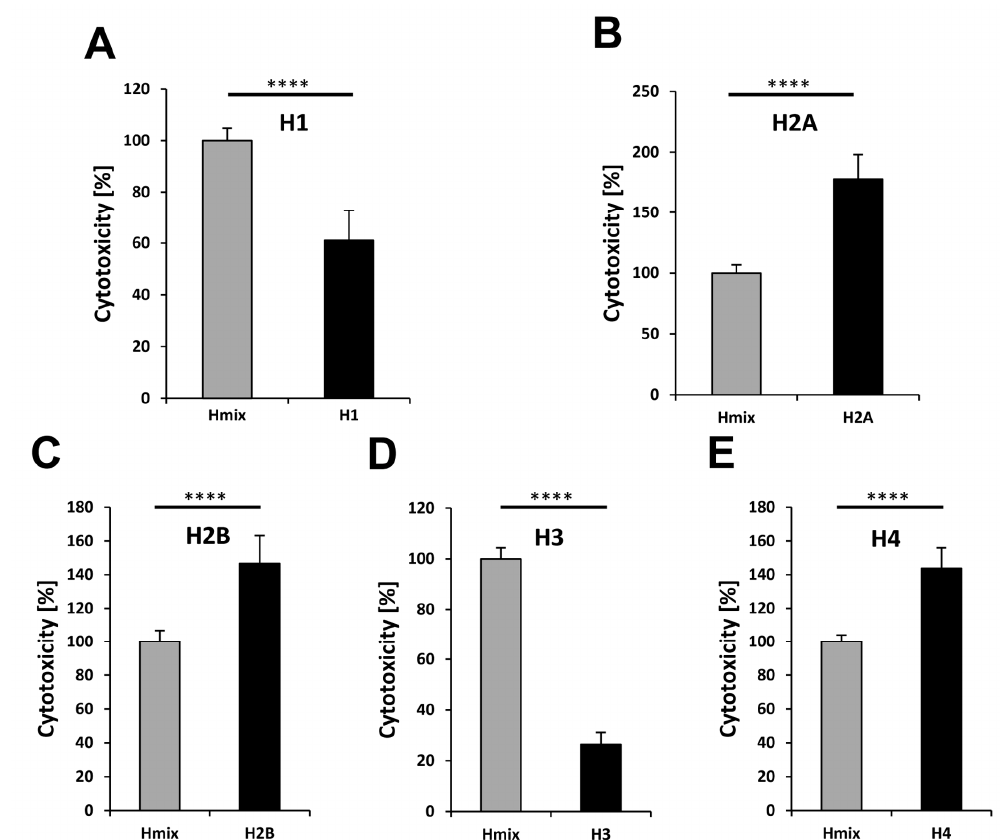
Figure 6. Cytotoxicity of individual histones compared to a mixture of histones. The cytotoxic effects of the histone mix (60 µ g/mL) and individual histones (60 µ g/mL) on 5B8 cells are shown. The histone-mix (gray bar) was defined as 100%. ( A ) Histone H1; ( B ) Histone H2A; ( C ) Histone H2B; ( D )